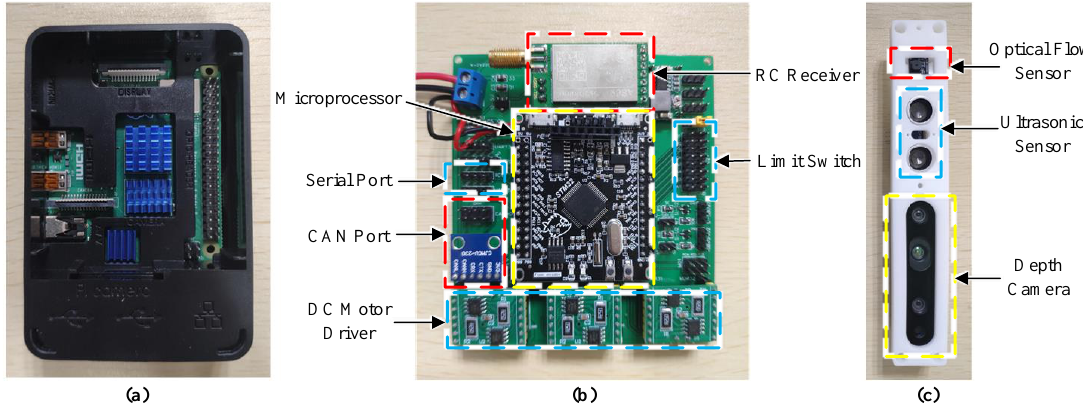
Figure 5. ( a ) Control computer, ( b ) driving board, ( c ) and sensor system.